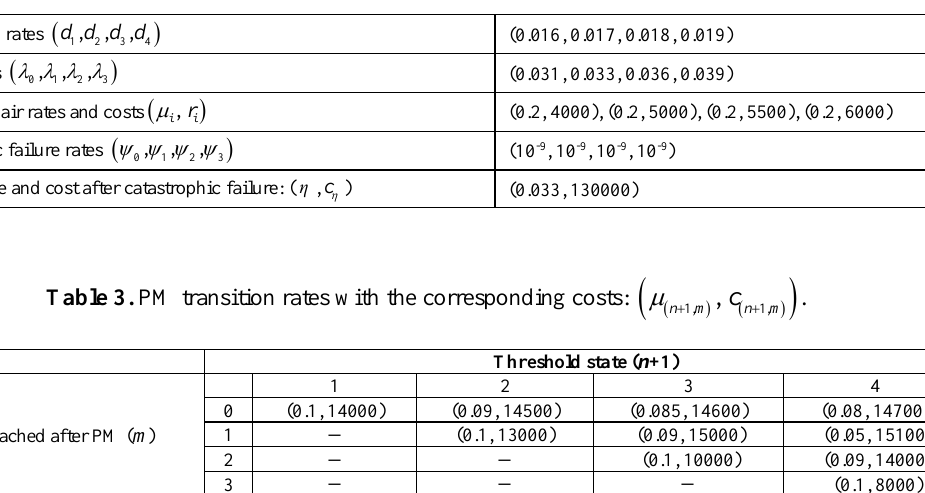
Table 2. Transition rates.